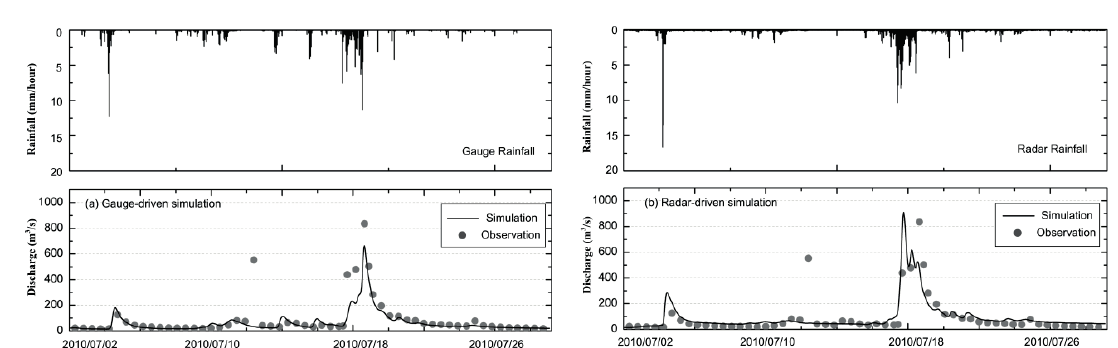
Fig. 5 Comparison of simulation by different rainfall inputs at Wenquan basin in 2010 July.